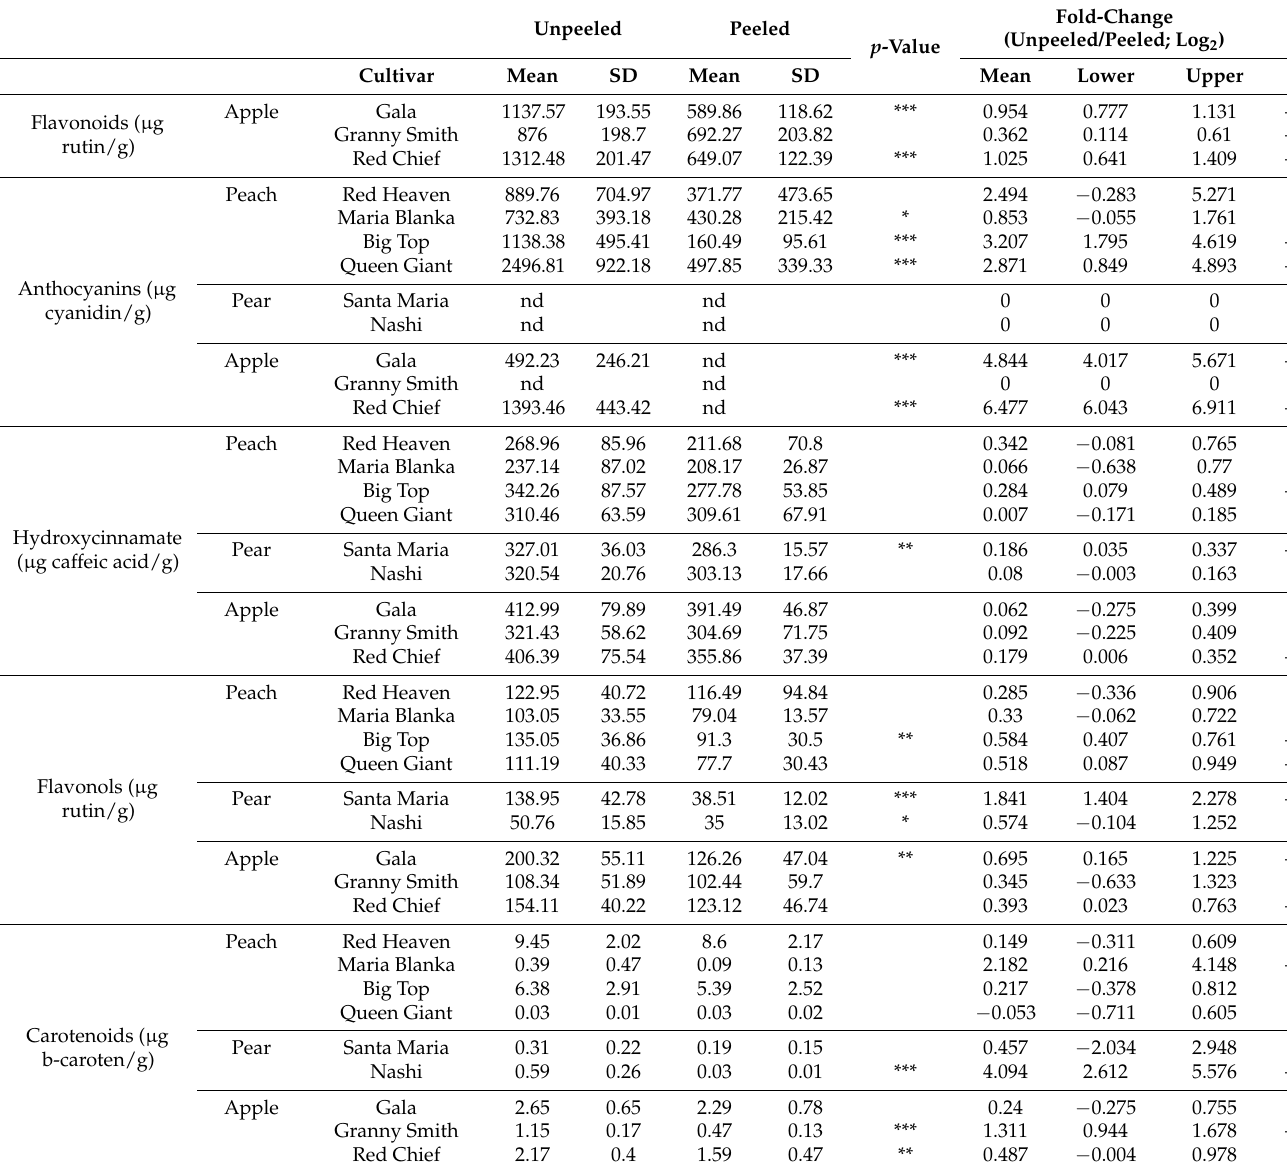
The dry weight (DW) of unpeeled Red Heaven peach ( P ≤ 0.01 ), Nashi pear, and Gala apple ( P ≤ 0.05 ) were higher compared to the peeled ones. Increased levels of DW in unpeeled fruits of all cultivars were determined as fold-change that had positive values in both 95% lower and upper confidence intervals, with the only exception of the Santa Maria pear (Table 1). The antioxidant capacity of the unpeeled Red Haven peach ( P ≤ 0.01 ) and Big Top nectarine ( P ≤ 0.05 ), Nashi pear ( P ≤ 0.001 ), and the three apple cultivars (Granny Smith ( P ≤ 0.01 ), Gala, and Red Chief ( P ≤ 0.001 )) were higher compared to the peeled ones (Table 1). A higher antioxidant capacity of unpeeled fruits of all tested cultivars, except for Santa Maria pear, was noticed (Table 1). Polyphenol content of unpeeled Red Haven ( P ≤ 0.05 ), Granny Smith ( P ≤ 0.01 ), Nashi, Gala, and Red Chief ( P ≤ 0.001 ) fruit was in higher abundance than the corresponding peeled fruits (Table